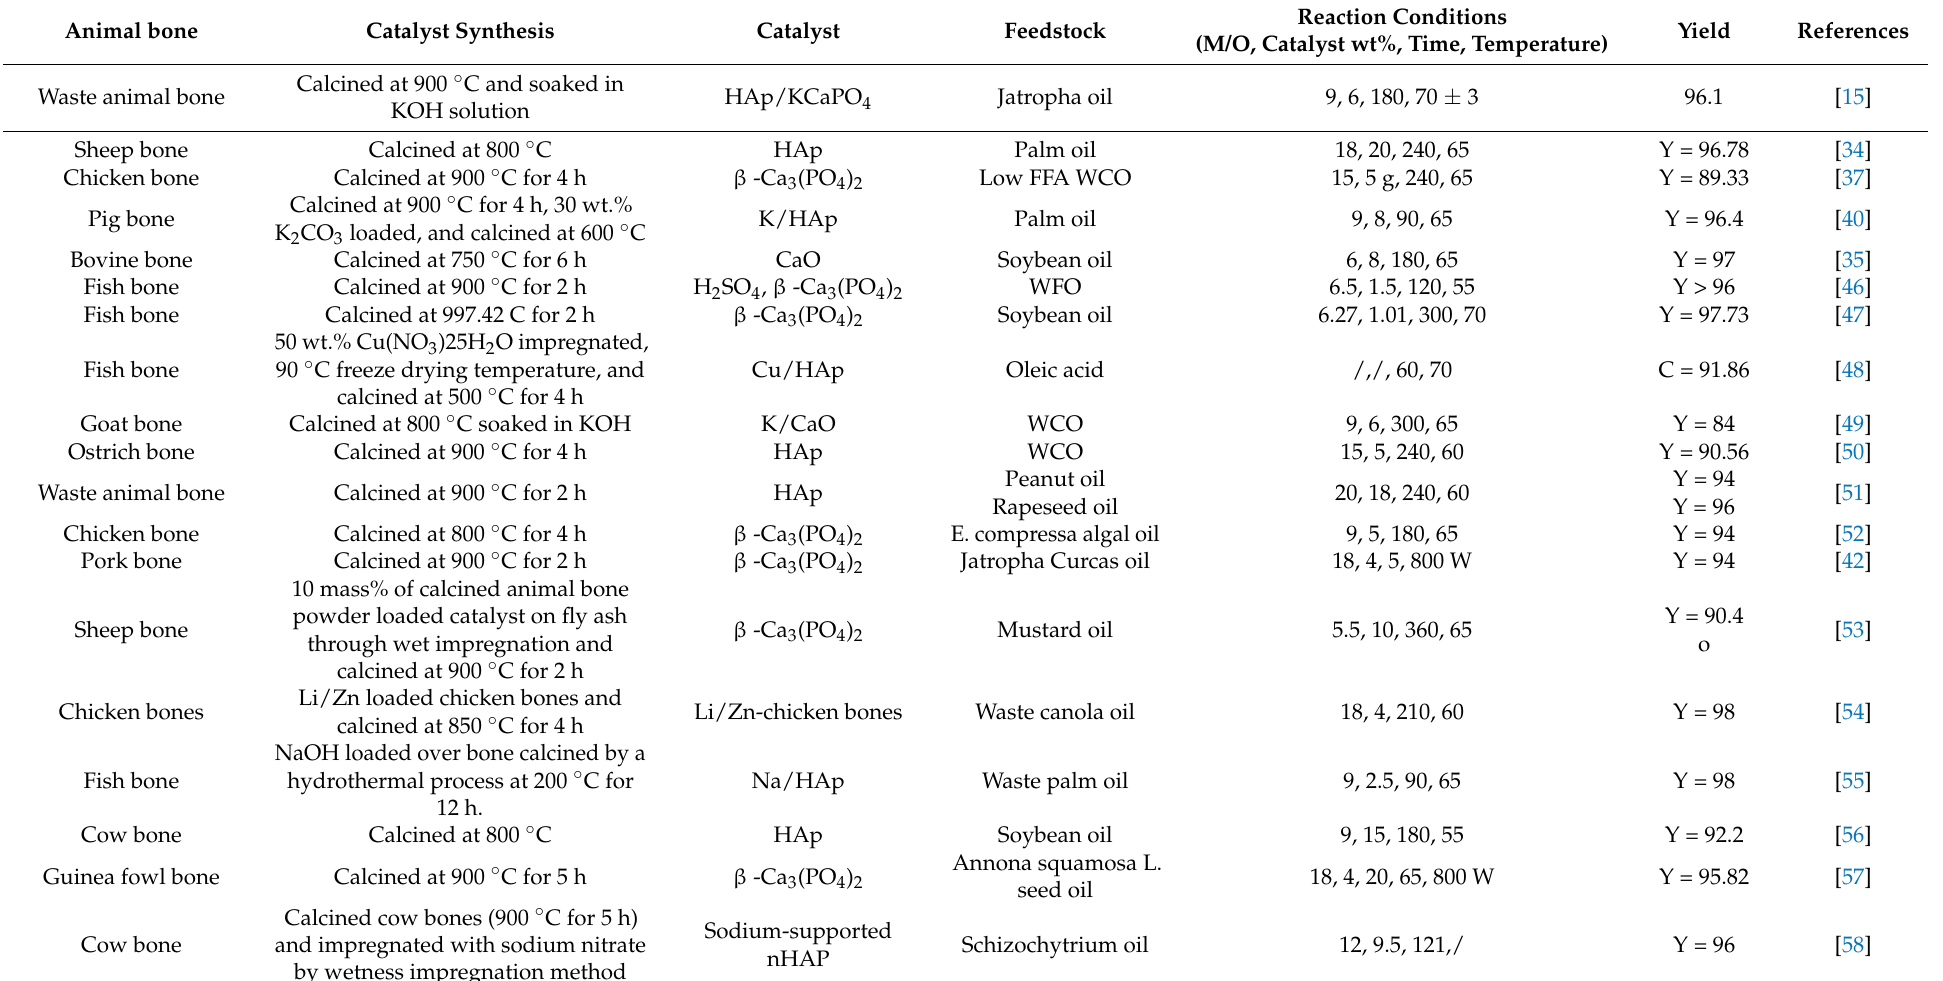
Table 1. Various animal sourced bone-based catalysts and their biodiesel